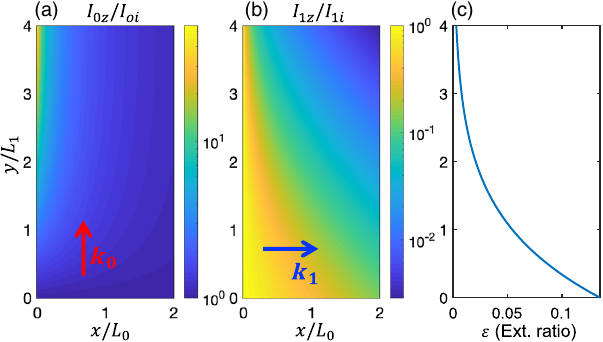
FIG. 5. Spatial nonuniformity of the nonlinear polarizer in the 90° crossing geometry. (a) Intensity of the auxiliary beam (propagating towards y > 0 ), (b) intensity of the probe (propa- gating toward x > 0 ), (c) extinction ratio ε ð y Þ ¼ I 1 [i.e., lineout of (b) at x=L 0 ¼ 2